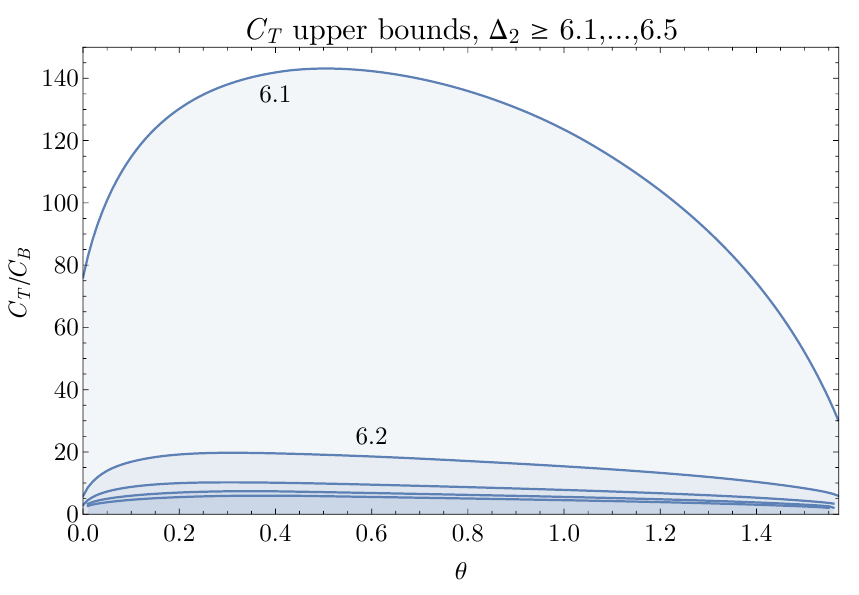
Figure 10 . Upper bounds on C T as a function of (cid:18) in 3d CFTs for di(cid:11)erent gaps between the stress tensor and the second parity-even spin-2